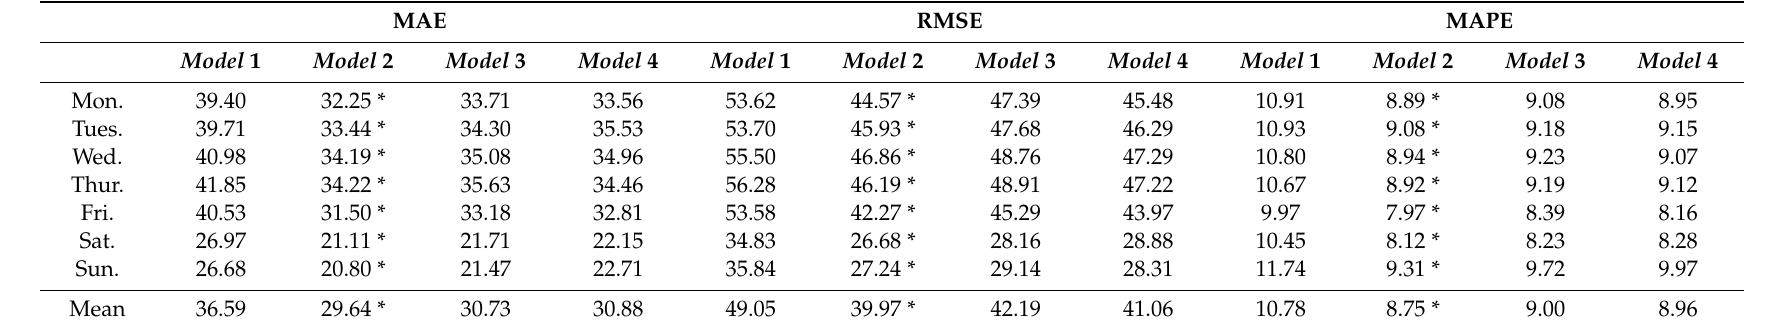
Table 5. Average MAE, RMSE, and MAPE values of all paths from Monday to Sunday of the four assimilation models. MAE RMSE MAPE Model 1 Model 2 Model 3 Mon. Tues. Wed. Thur. Fri. Sat. 26.97 Sun. 26.68